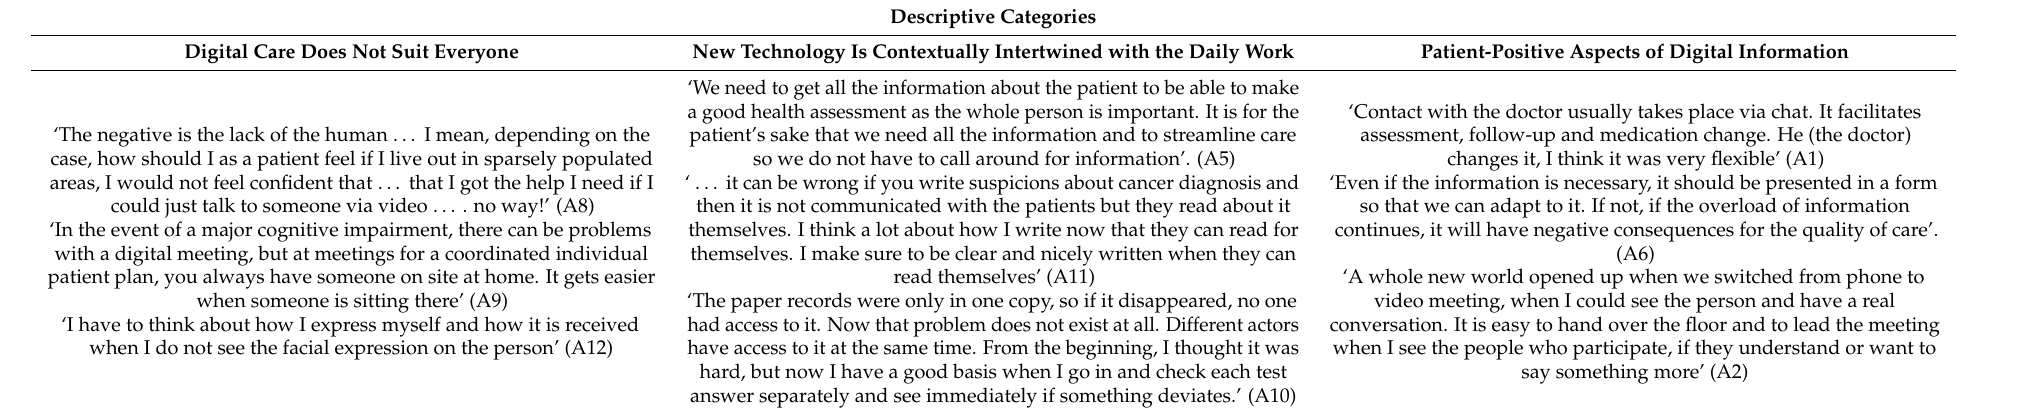
Table 3. Summary of the inductive analysis process departing from the matrix’s